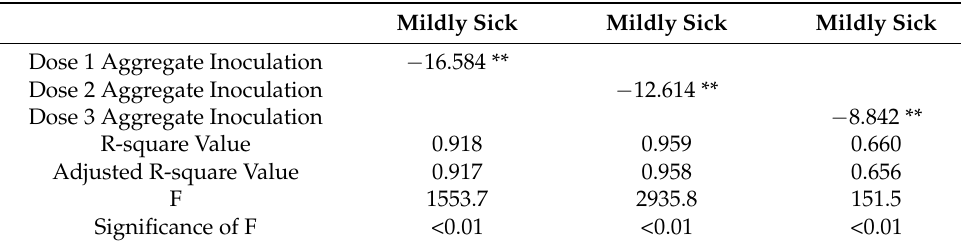
Table 10. Regression between the mildly sick patients and doses 1, 2, and 3.